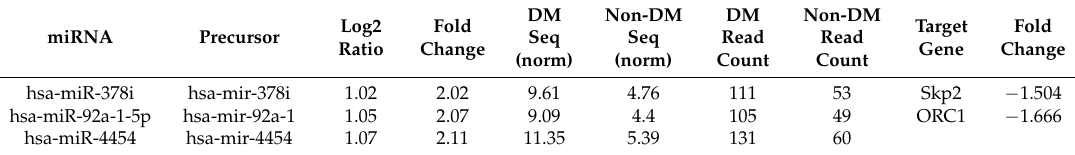
Table 3. Potential microRNA–mRNA interactions identified in diabetic PTECs.